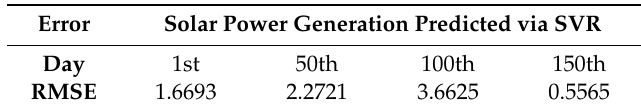
Table 2. Performance comparison of predictor systems using predicted and actual